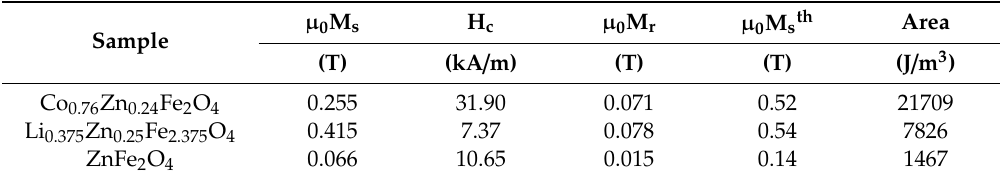
Figure 2. ( a ) Room-temperature major dc-hysteresis loops of all the studied samples; ( b ) dc-hysteresis loops areas as a function of the vertex field for all the studied ferrites. Table 2. Saturation magnetization ( µ 0 M s ), coercive field ( H c ), magnetic remanence ( µ 0 M r ), theoretical saturation magnetization ( µ 0 M sth ) at 0 K and the area enclosed by the major dc-hysteresis loops for all the